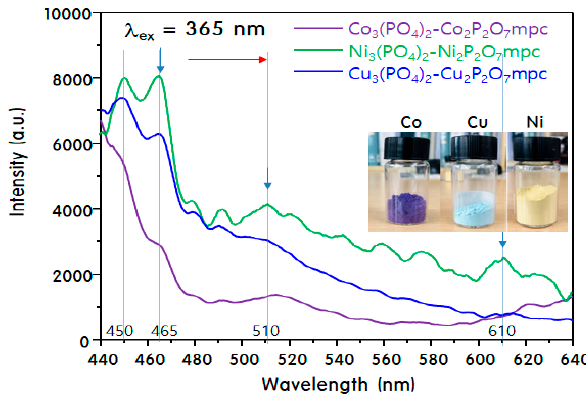
Figure 5. PL spectra of the M 3 (PO 4 ) 2 -M 2 P 2 O 7 mpc (M = Co, Ni, and